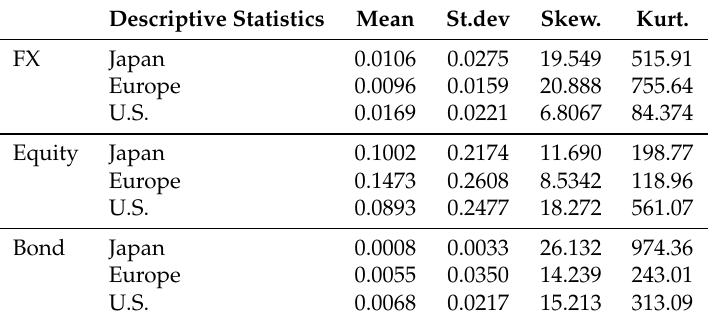
Table 1. Descriptive statistics for daily estimates of minimized realized volatility in three financial asset markets, across the three trading zones for the period 22 July 1998 to 29 December